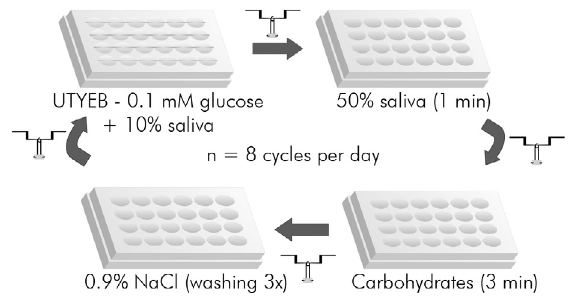
Figure 1. Diagram of the treatments administered 8